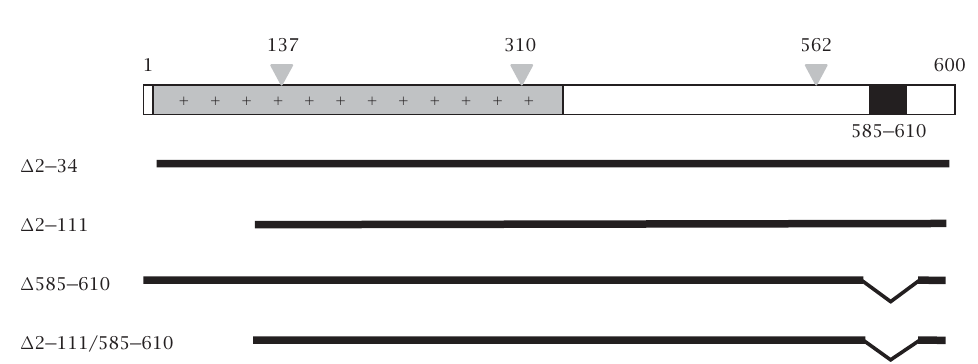
Figure 1: The 660 amino acid protein (pORF 2 ) encoded by the HEV ORF 2 is shown schematically, with three major regions: the extreme N-terminus, containing the putative signal sequence (open box), the highly basic N-terminal half of the protein ( + ) and a C-terminal hydrophobic stretch (filled box). The positions of three potential N-linked glycosylation sites are shown at amino acid residues 137 , 310 , 562 . The deletion mutants used in this study are also shown